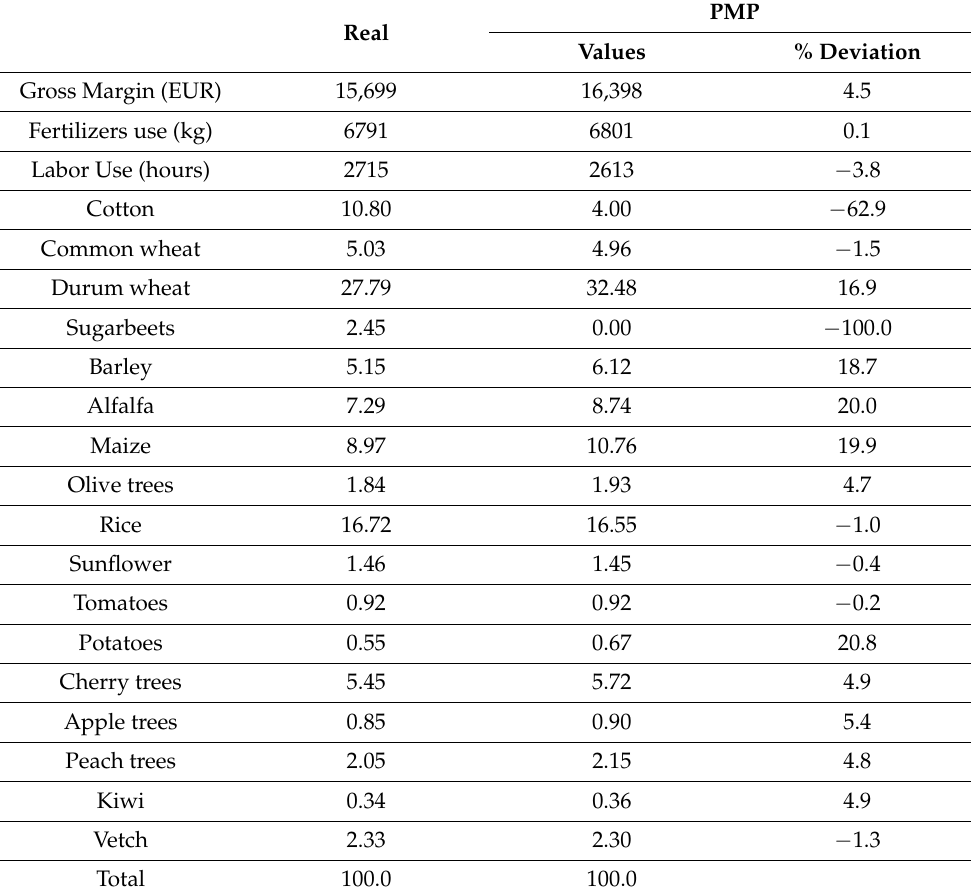
Table 3. Comparison of the Real crop plan vs. PMP model crop plan. Source: Our